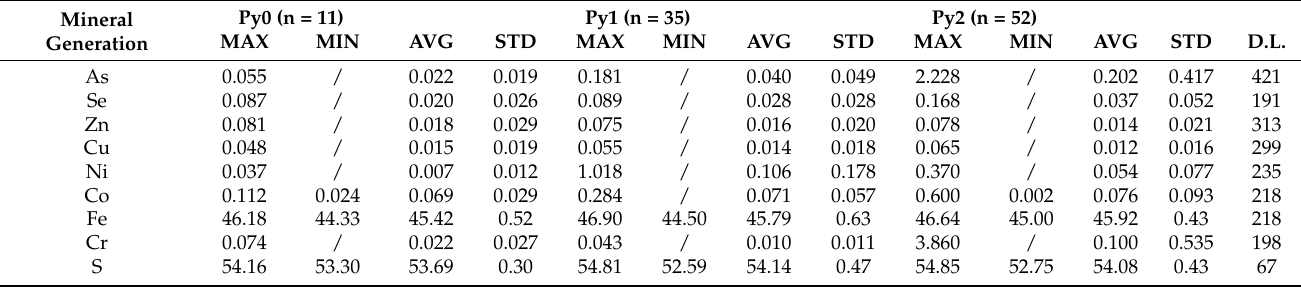
Table 1. Electron probe analyses of different types of pyrites in the Xinjiazui gold deposit. Mineral